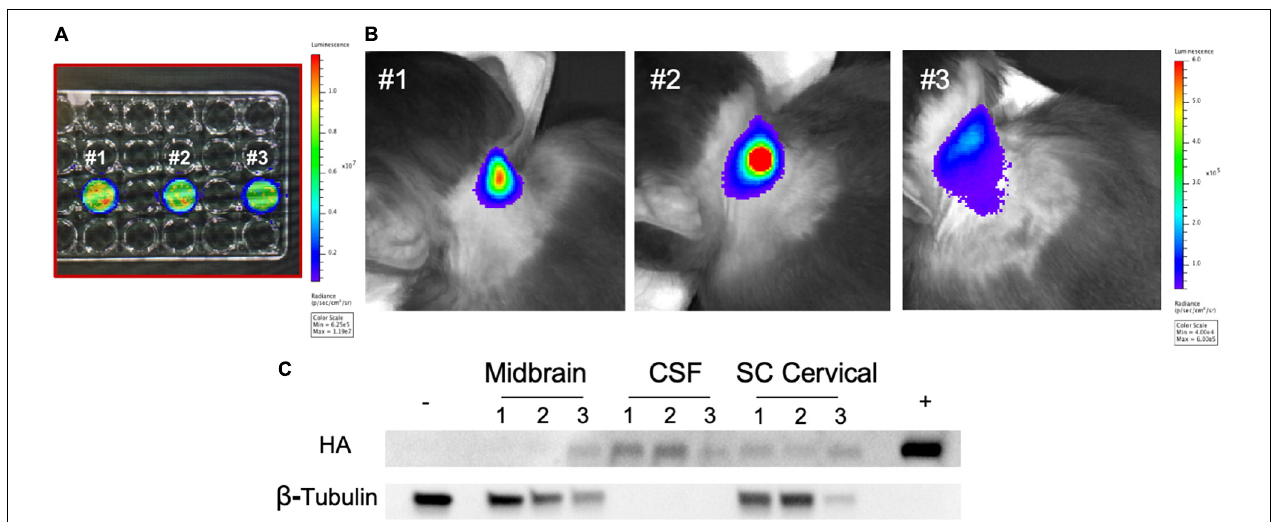
FIGURE 7 | Intrathecal administration of autologous rhMSC in young rhesus monkeys. (A) Autologous rhMSC were collected per standard protocol and cells transduced with a lentiviral vector expressing firefly luciferase. rhMSC were confirmed to express luciferase by bioluminescence imaging (BLI) prior to intrathecal injection. Numbers reflect transduced rhMSC from monkey #1, monkey #2, and monkey #3. (B) BLI was performed immediately following intrathecal administration of rhMSC expressing firefly luciferase according to established protocols. The location of the firefly luciferase-expressing autologous rhMSC post-injection are shown in representative images from each rhesus monkey, consistent with findings in other cell and gene transfer studies where BLI has been used (Tarantal et al., 2009; Tarantal and Lee, 2010). (C) Western blot shows the presence of zinc finger (ZF) 3 weeks following injection. ZF protein was delectable in the CSF (three animals), midbrain (one animal), and spinal cord (two animals). Historical whole brain lysate from non-treated rhesus monkeys was used as a negative control. ZF-MSC lysate used as a positive control. Numbers reflect animal number as described in (A)